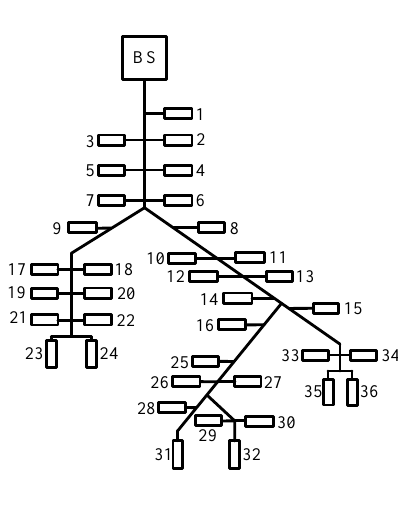
Figure 1. Tree-type network.